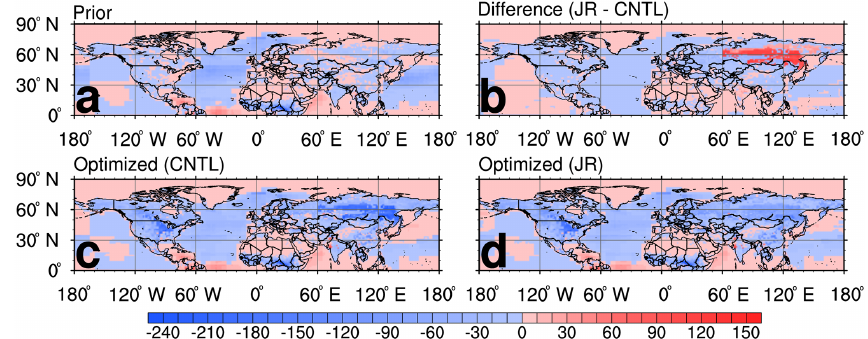
Figure 2. Average biosphere and ocean fluxes (gCm − 2 yr − 1 ) from 2002 to 2009 of (a) the prior flux, (b) the difference between the optimized fluxes in the JR and CNTL experiments, (c) the optimized flux in the CNTL experiment, and (d) the optimized flux in the JR experiment. Blue colors (negative) denote net CO 2 flux uptake while red colors (positive) denote net CO 2 release to the atmosphere. The difference is calculated by subtracting surface CO 2 flux of the CNTL experiment from that of the JR